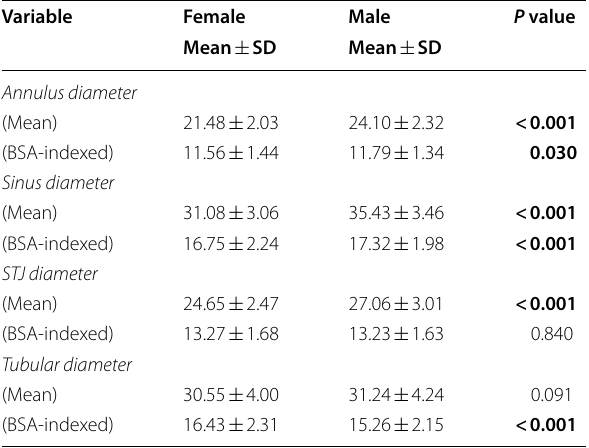
Table 15 Comparison of ascending aortic diameters according to gender